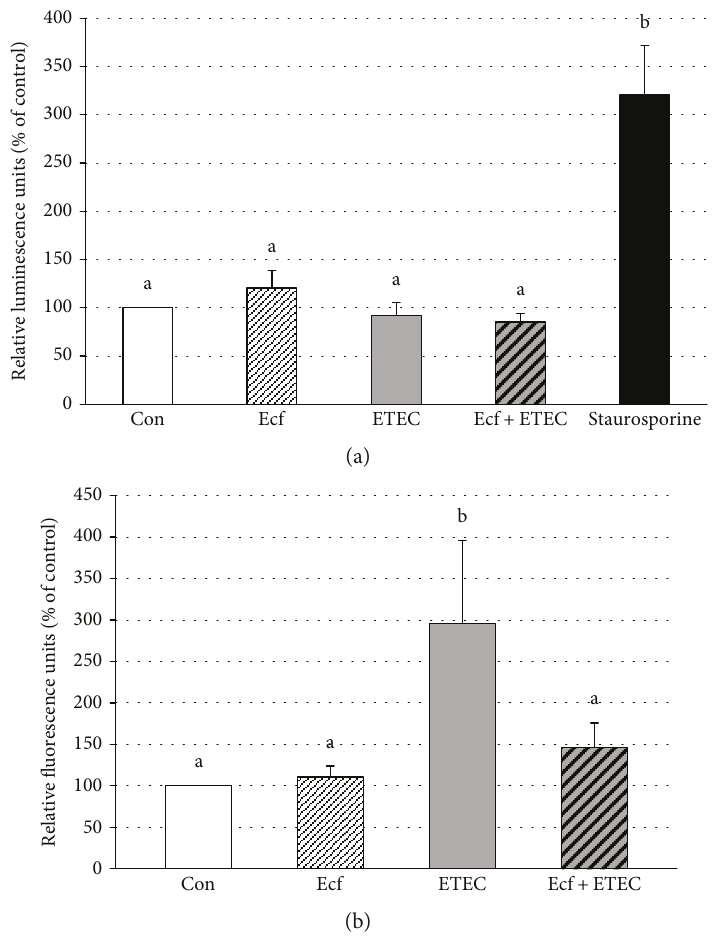
Figure 6: Apoptosis (a) and cytotoxicity (b) of IPEC-J2 cells after treatment with bacterial strains (Ecf, ETEC, and Ecf + ETEC) or without bacteria (Con = control) as assessed by caspase-3/7 activity in luminescence assay for apoptosis and by a dead cell protease fl uorescence assay for cytotoxicity [means ± SEM]. Measurements were taken after 6h. Groups di ff er signi fi cantly ( P ≤ 0 05 ) when marked with di ff erent letters, (e.g., a, b) in the fi gure. N = 4 (apoptosis assay) and N = 5 (cytotoxicity assay) independent